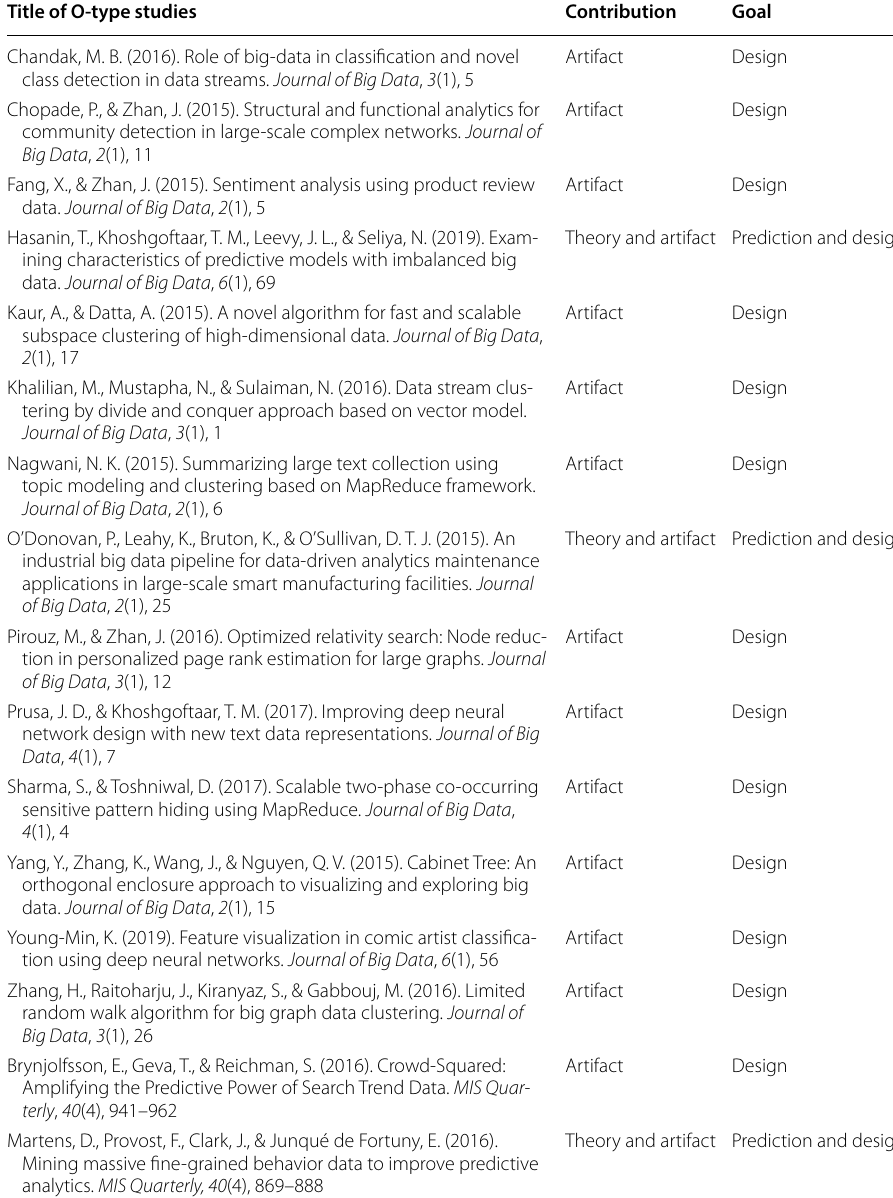
Table 7 Sample of studies of data science as an object of